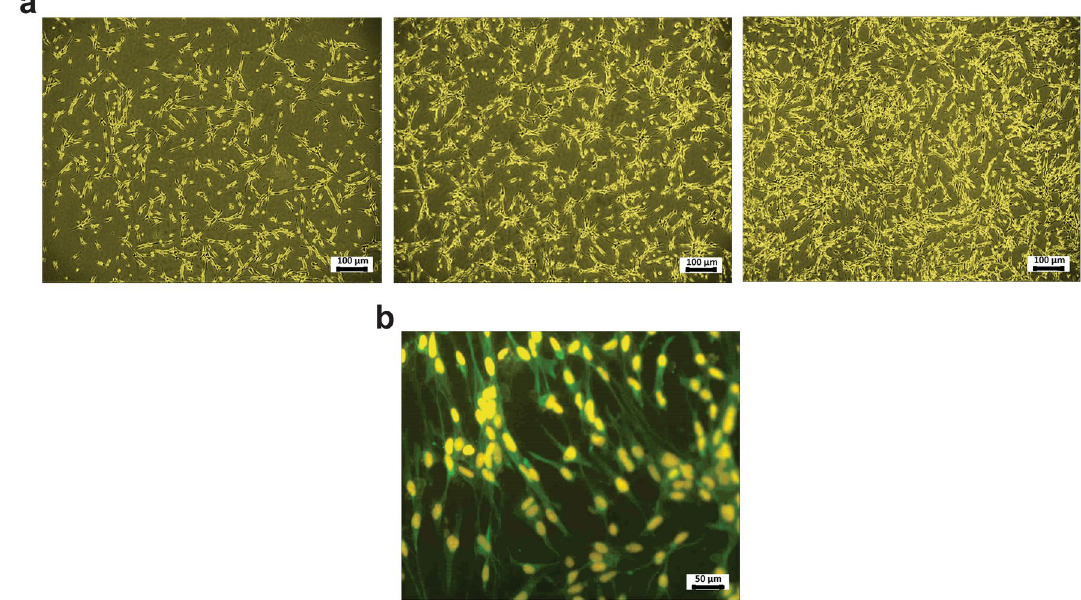
Immunocytochemistry of hNS/PCs. Nestin as a neural stem cell marker was conjugated with FITC and nuclei were stained with